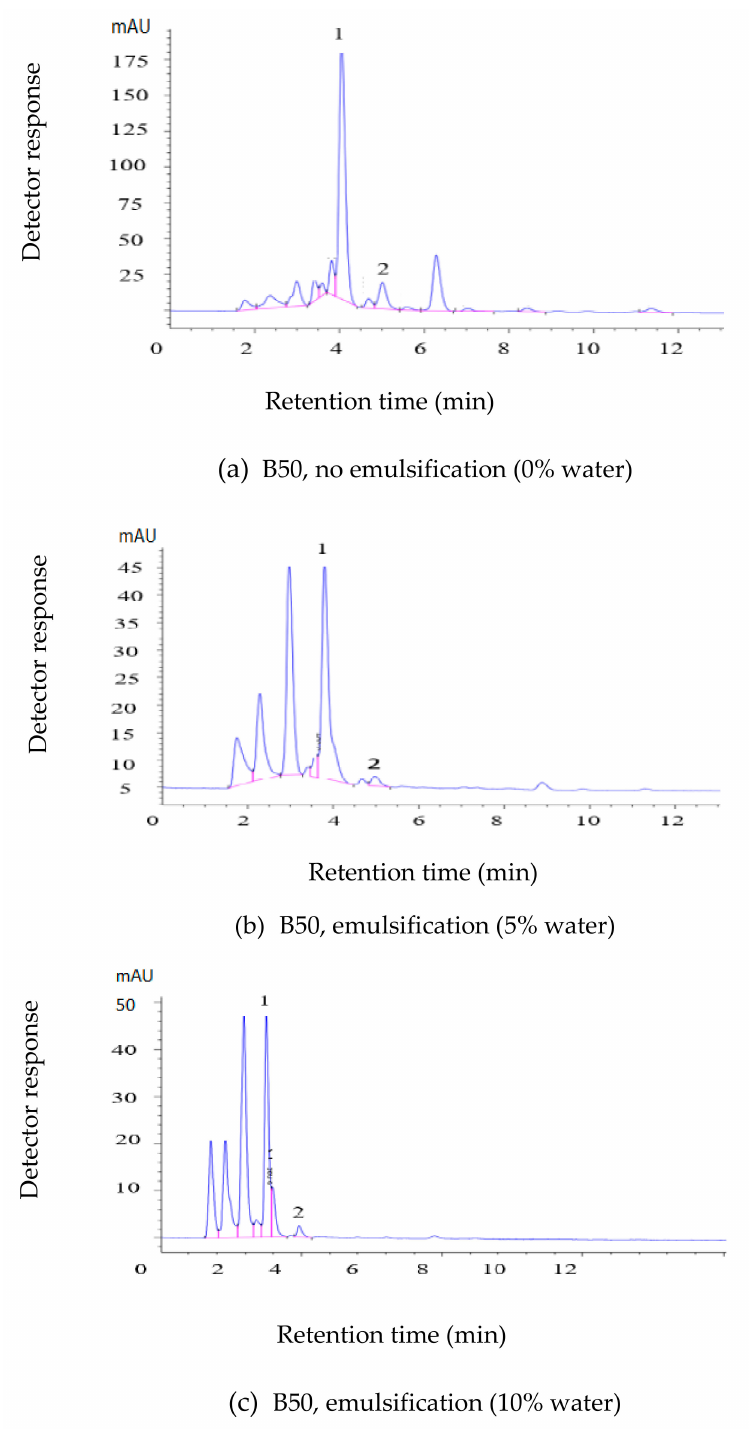
Figure 10. Liquid chromatogram of B50, ( a ) no emulsion, ( b ) 5% water, ( c ) 10%